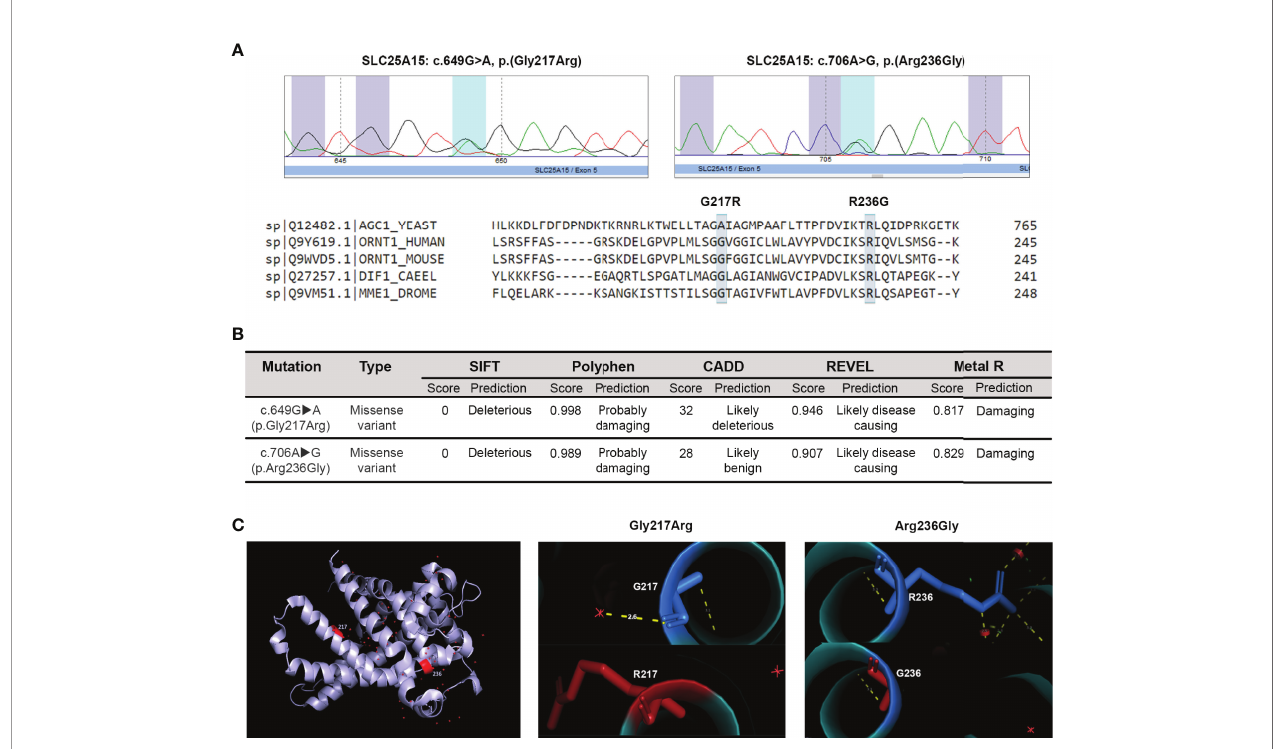
FIGURE 1 | In silico analysis of c.649G>A (p.Gly217Arg) and c.706A>G (p.Arg236Gly) mutations on the ORC1 protein structure and function . (A) Partial electropherograms showing the detected mutations. Multiple alignment of the modi fi ed ORC1 aminoacid residues with the protein sequence from different species using the Clustal W2 software. (B) In silico validation of the two SLC25A15 gene mutations identi fi ed. (C) Modeling of the tridimensional protein structural changes introduced by the two identi fi ed mutations using the human ORC1 homology model. Normal residues are marked in blue (top) and the changes introduced by mutations in red